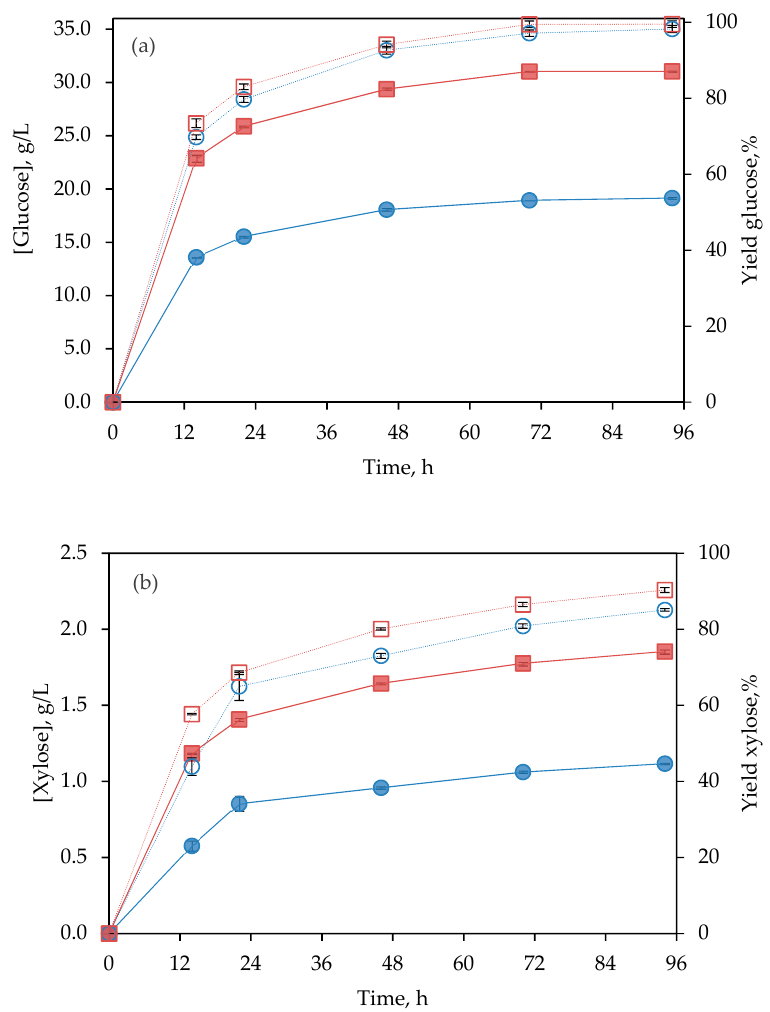
Figure 4. Time course of enzymatic hydrolysis of subW-pretreated BSG at different solids’ loading ● ○ 5% ( w/v ), ■ □ 8% ( w/v ); ( a ) glucose; ( b ) xylose. Monosaccharides’ concentration (g/L) (filled symbol) and yield (open symbol), expressed as g monosaccharide per 100 g of monosaccharide in pretreated BSG. Experiments were conducted in duplicate. Analytical measurements were conducted in triplicate.